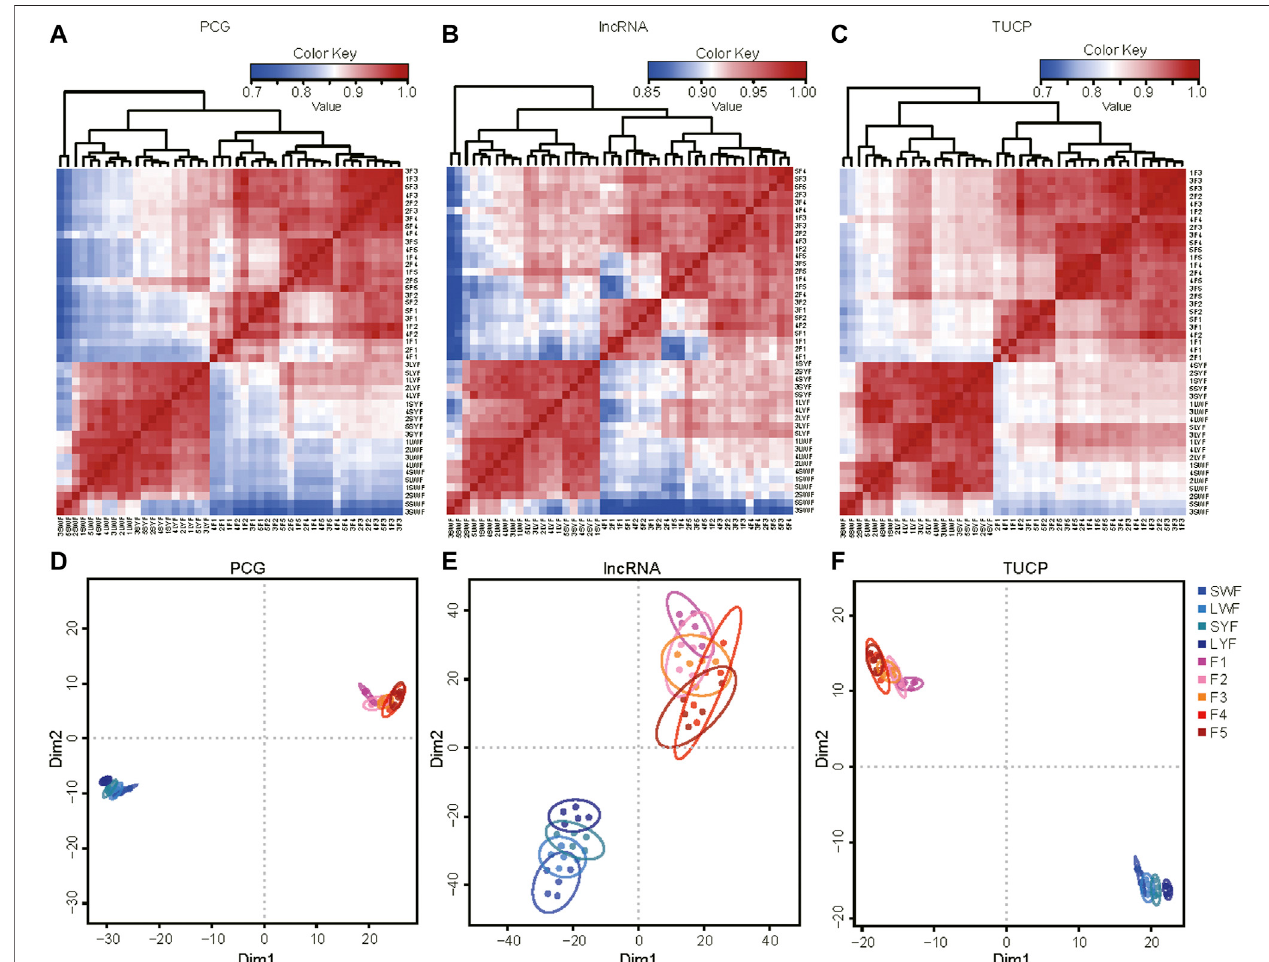
FIGURE 2 | The common DEGs in the pre-hierarchical follicles and hierarchical follicle GCs.